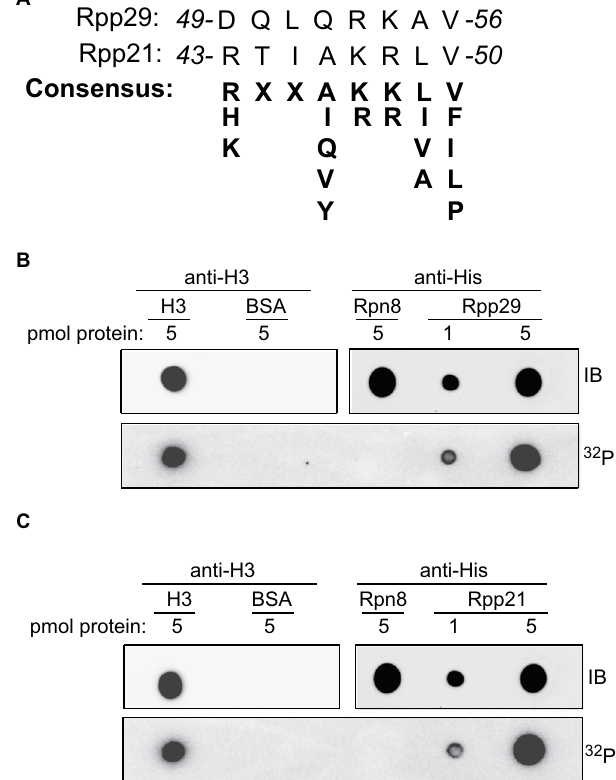
Figure 4. Rpp29 and Rpp21 bind poly(ADP-ribose) (PAR) in vitro . ( A ) Protein alignment reveals that Rpp29 and Rpp21 contain a PAR-binding consensus (bold letters). ( B ) PAR-binding assay with full-length, 6 × His- tagged recombinant Rpp29 and Rpp21 proteins. 6 × His-Rpn8 and BSA are shown as negative controls, whereas histone H3 is used as a positive control. IB: Immunoblot. 32 P: phosphate radiolabeled